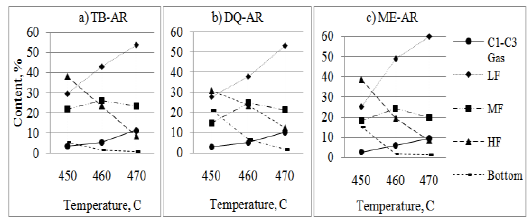
Figure 4. Relationship between content of products and hydrocracking temperature